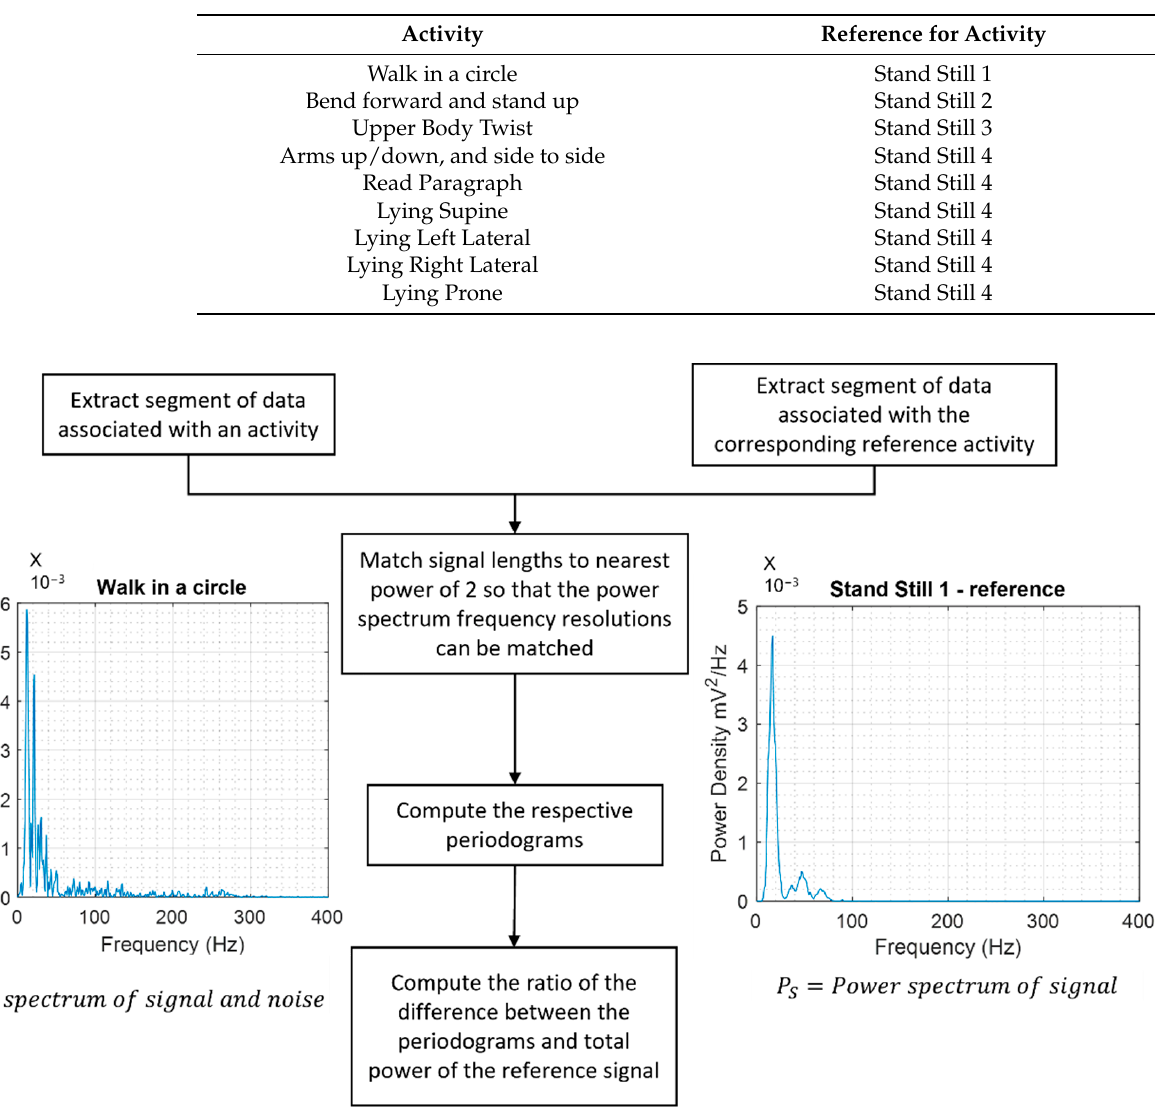
studied as a modulator of PCG quality during